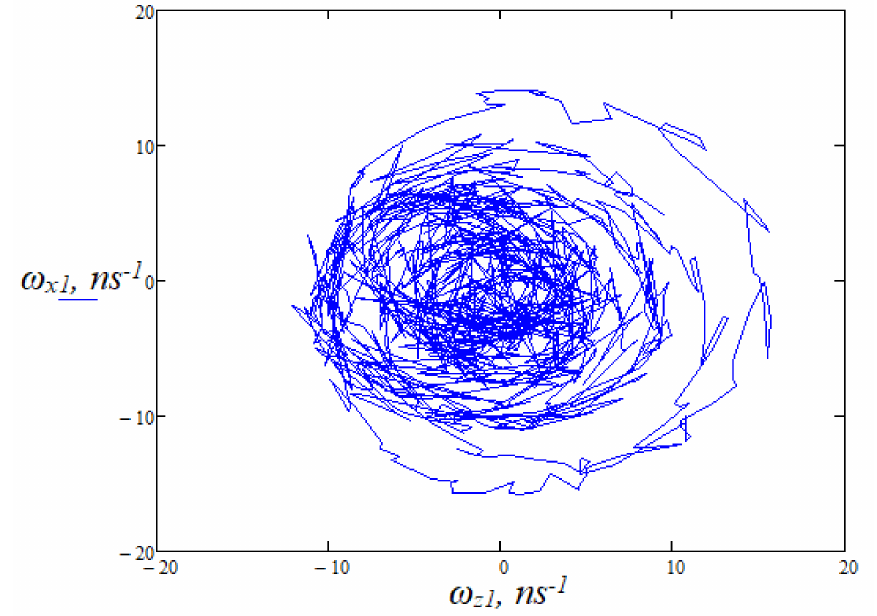
Figure 9. Herpoid composite molecular structure with freely moving